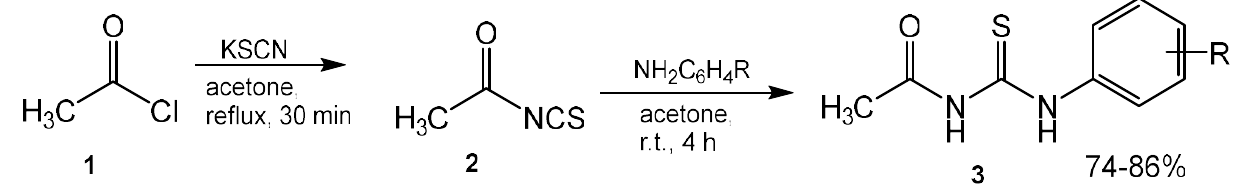
Fig. 1. Approaches to the synthesis of N